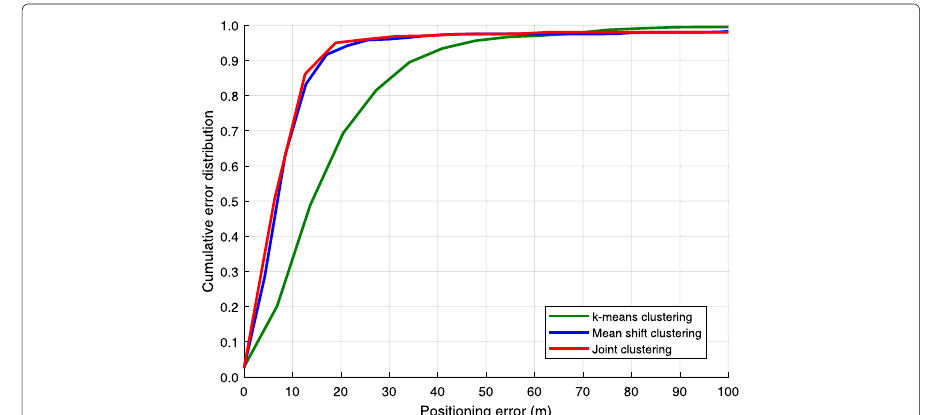
Fig. 11 Results of different clustering algorithms